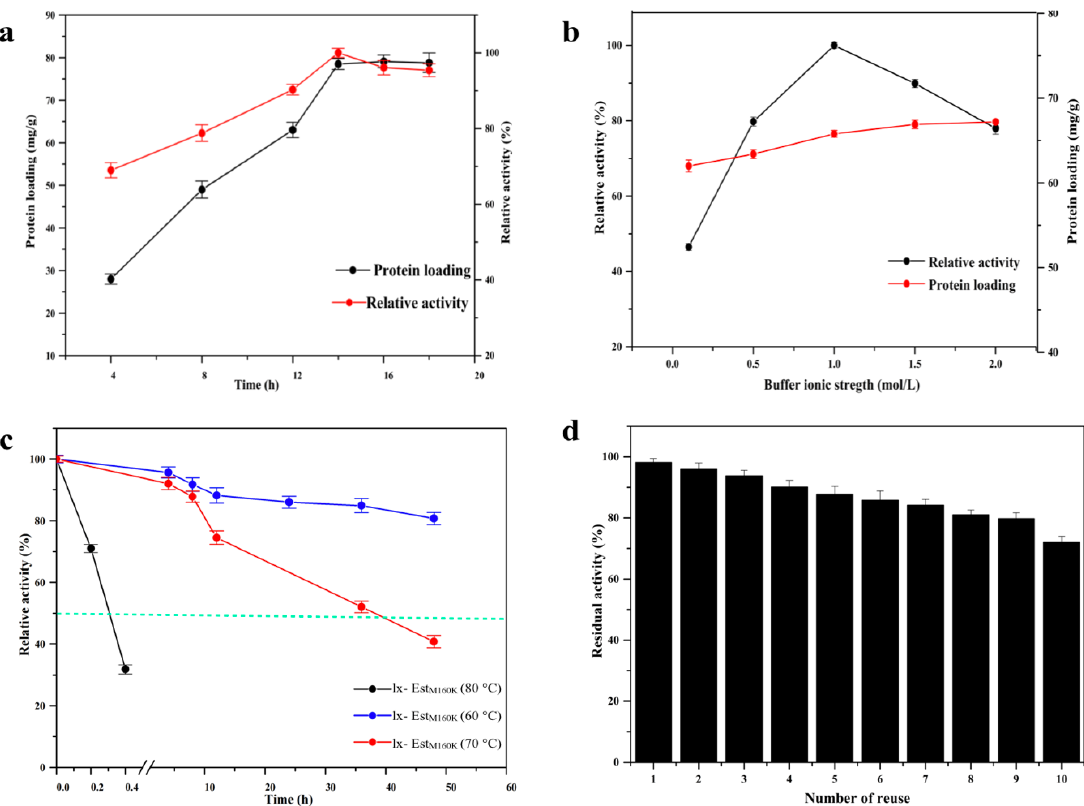
Figure 4. Optimization of Est M160K immobilization and performance of lx-Est M160K . ( a ) Effect of the immobilization time on enzyme stability. ( b ) Effect of buffer ionic strength on immobilization. ( c ) Thermal stability of immobilized Est M160K . ( d ) Reusability of immobilized lx-Est M160K .